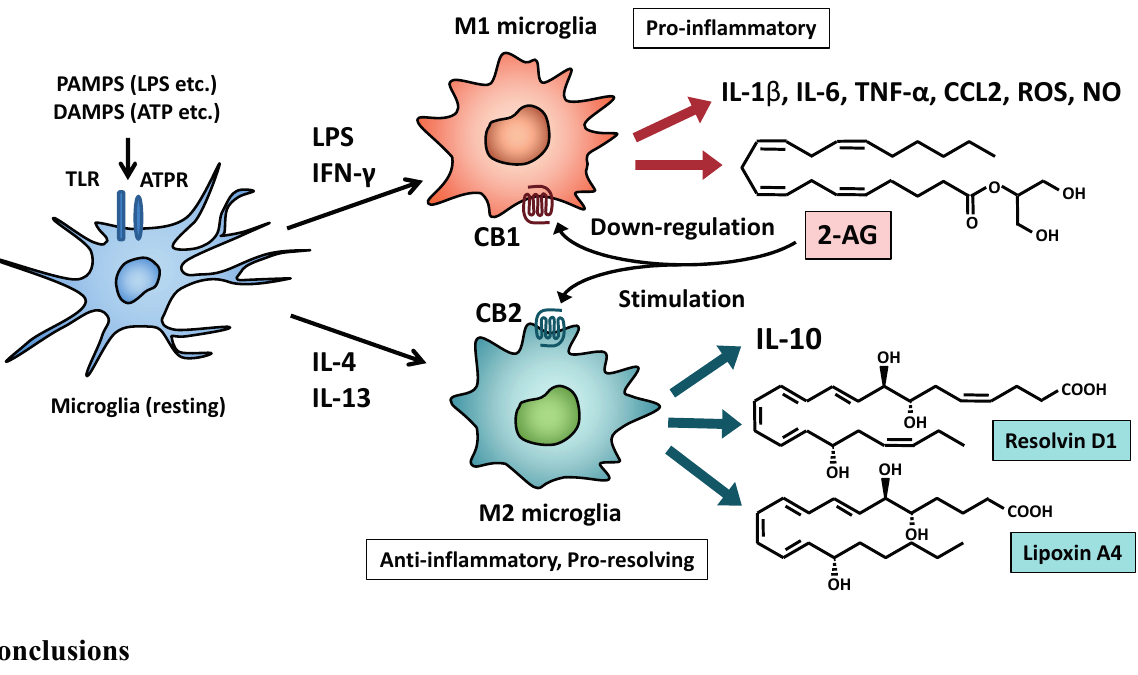
Figure 4. Possible roles of the cannabinoid receptors in M1/M2 polarization of microglia. 2-AG released from M1 microglia promotes production of pro-inflammatory cytokines and mediators by M1 microglia via CB 1 and then induces down-regulation of CB 1 . On the other hand, 2-AG stimulates M2 polarization of microglia via CB 2 . Subsequently, M2 microglia can produce IL-10 and anti-inflammatory/pro-resolving lipid mediators (resolvin D1 and lipoxin